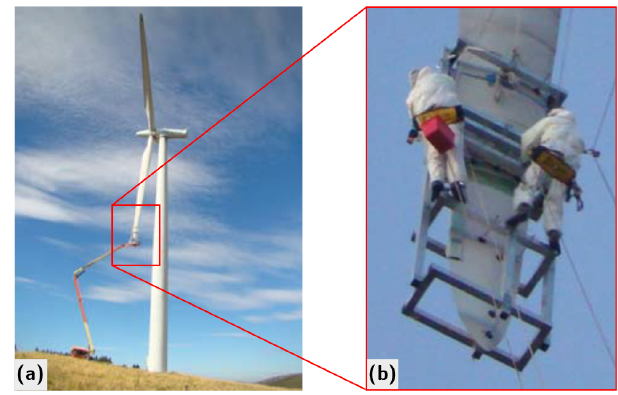
Figure 2. Siemens Bonus 1.5MW turbine (a) and on-site mounting of an RBE ( b ; Energiekontor,